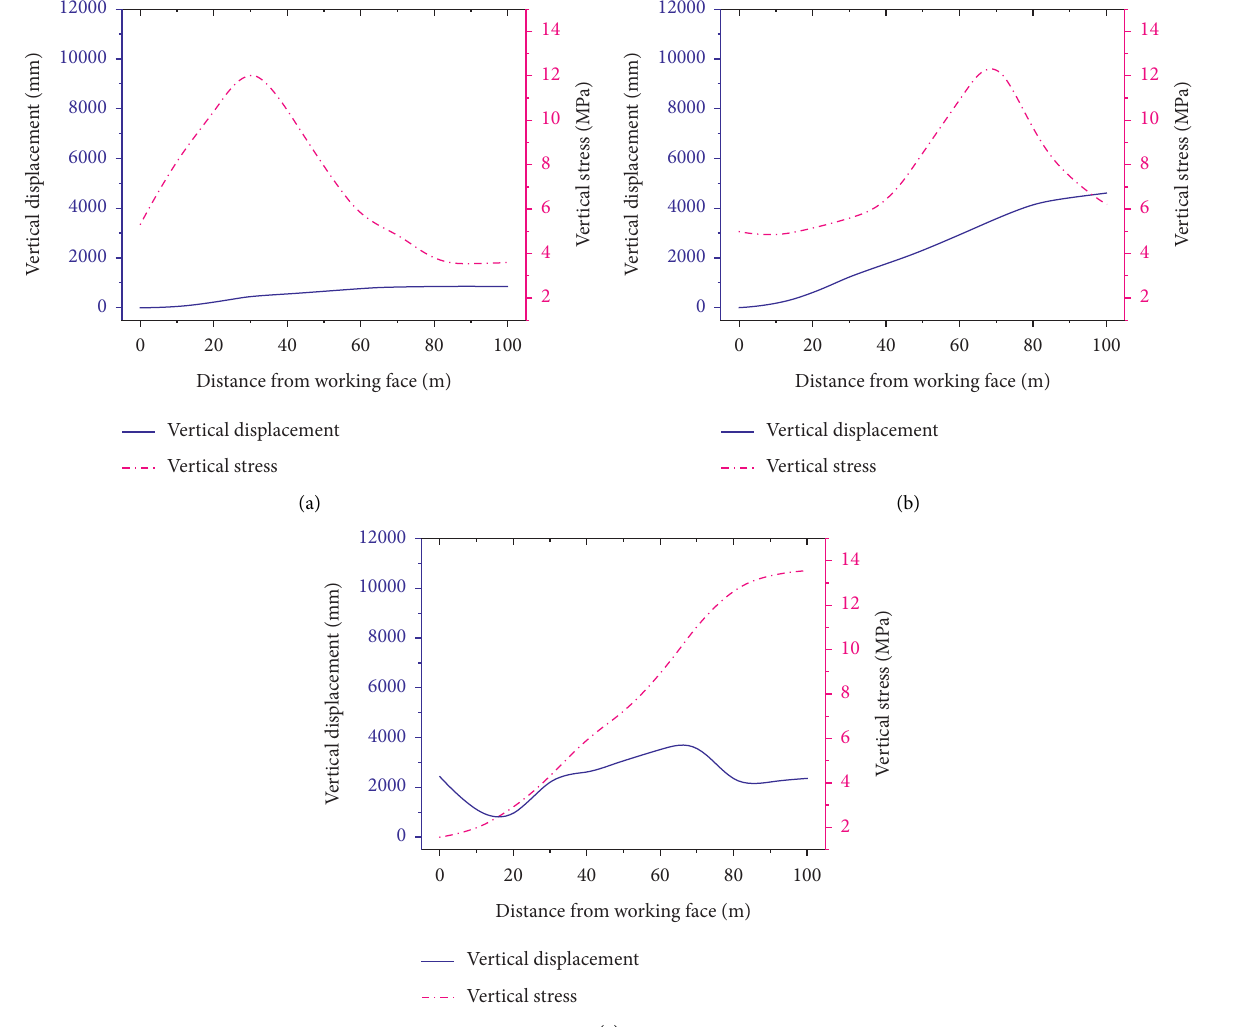
Figure 7: The vertical displacement and the vertical stress curve of the monitoring points. (a) Monitoring curve of “ a ” point. (b) Monitoring curve of “ b ” point. (c) Monitoring curve of “ c ” point.